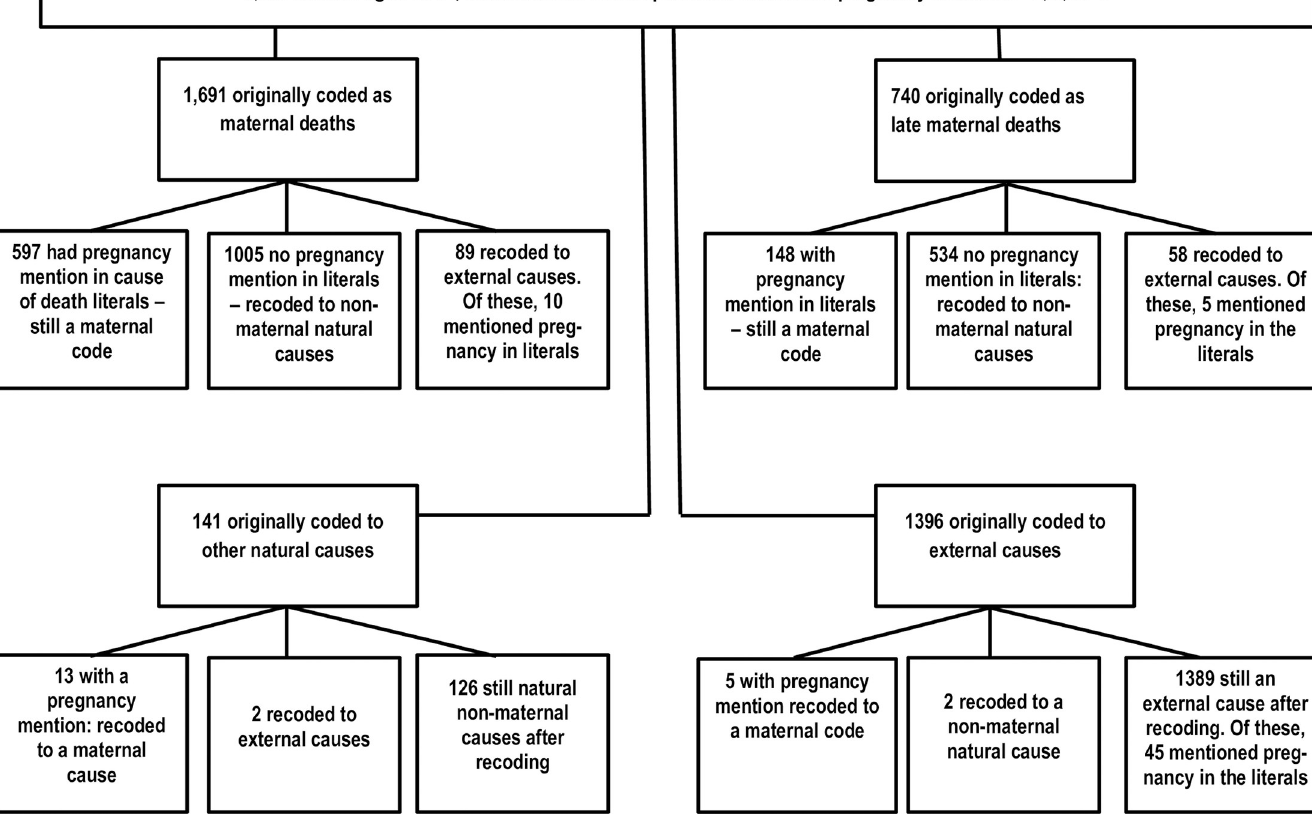
Fig 2. Flow chart for maternal mortality study, United States,